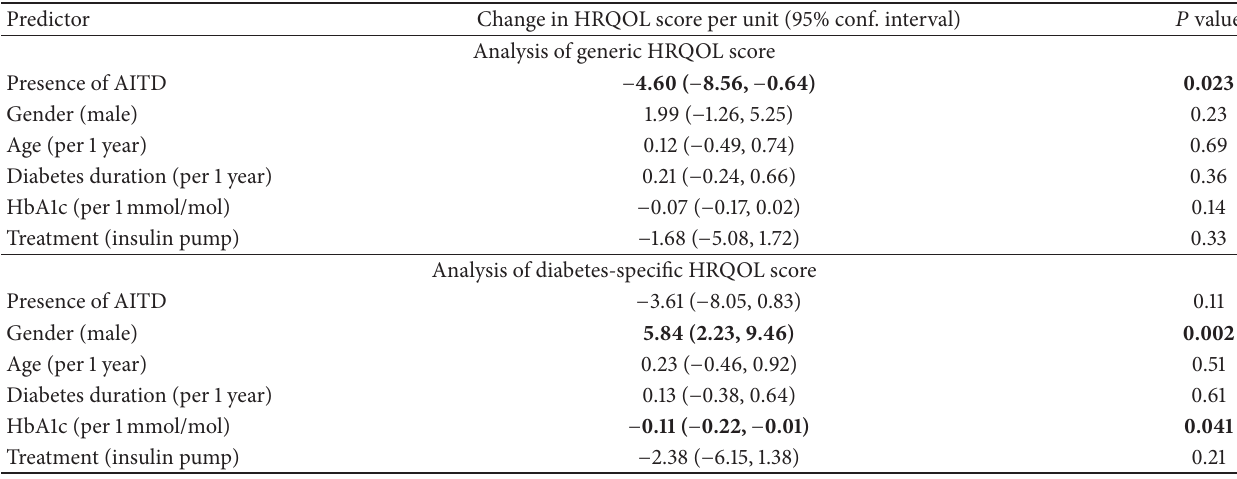
Table 3: The multivariable model describing the influence of AITD and other clinically relevant modifiers on the HRQOL. Predictor